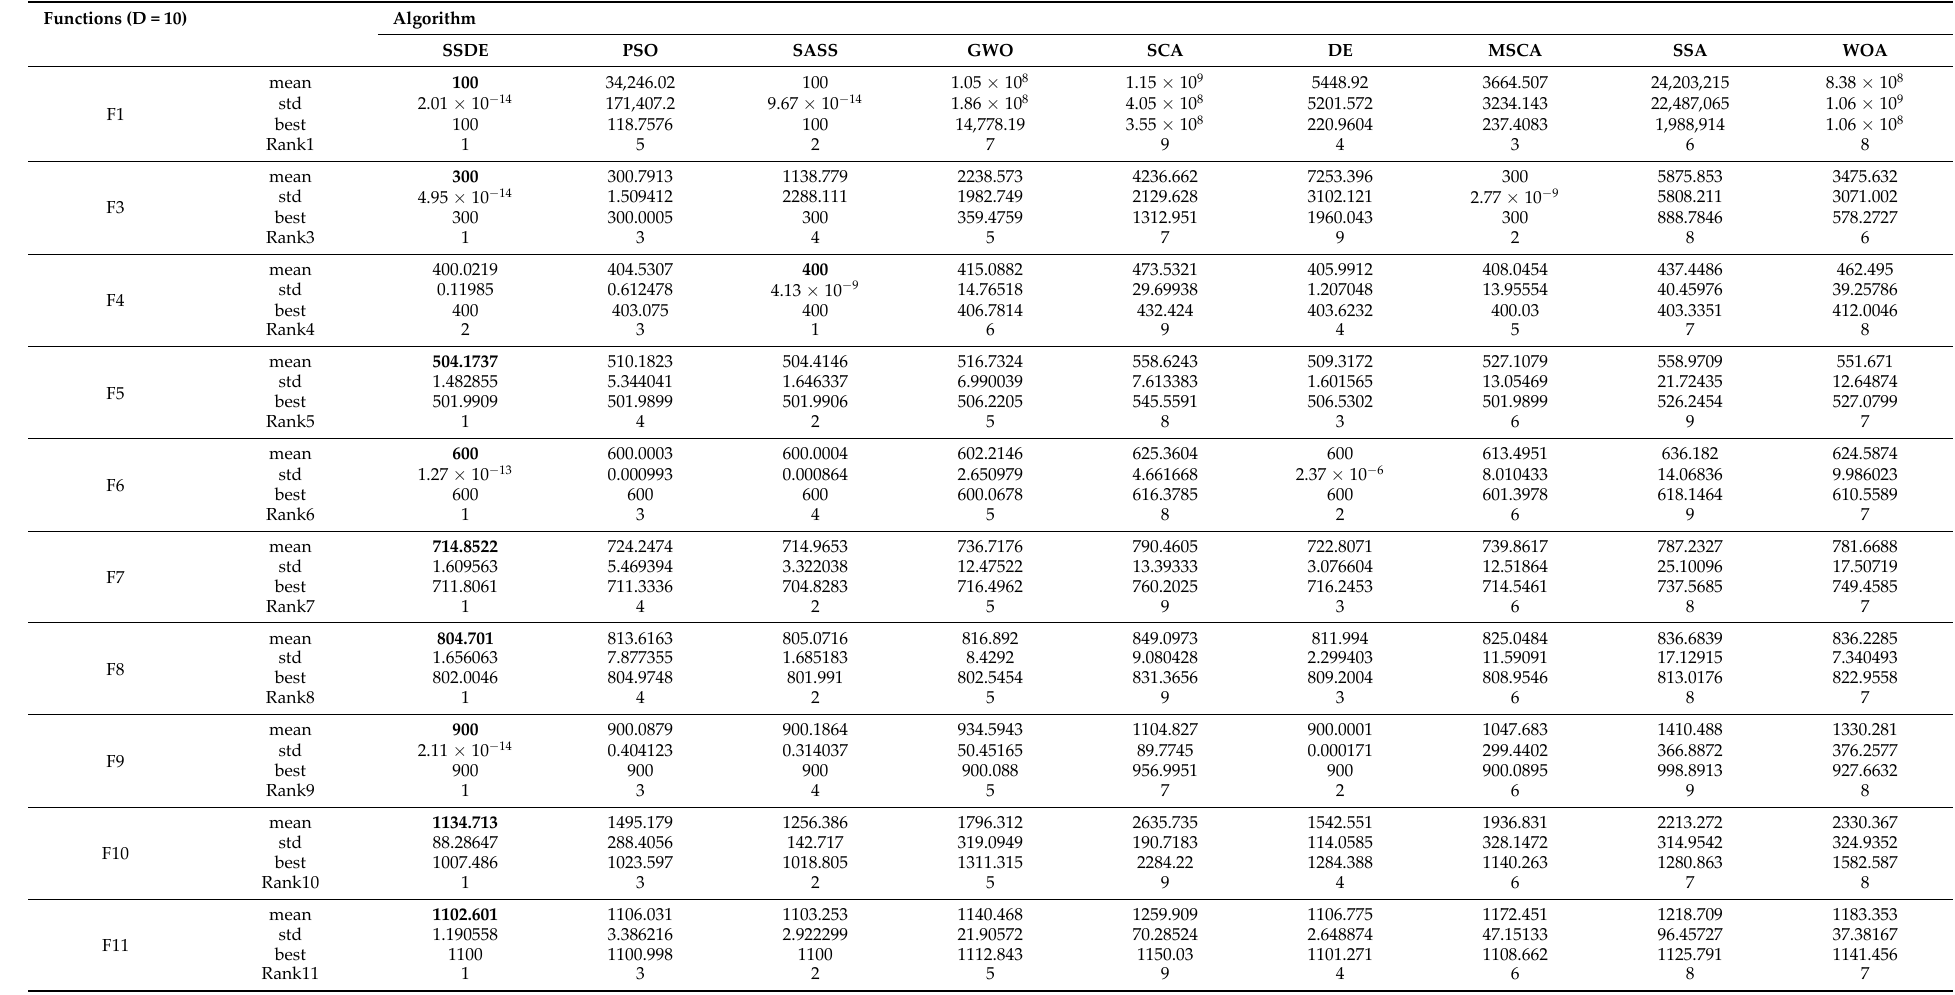
Table 2. Experimental results of IEEE CEC 2017 test problems with 10